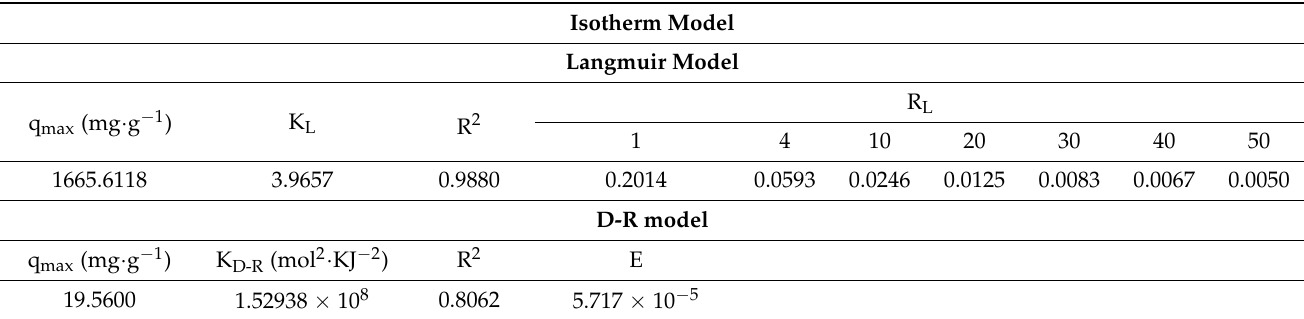
Table 3. Langmuir and D-R parameters for NP sorption by PS-MPs with particle size of 0.1 µ m. Isotherm Model Langmuir